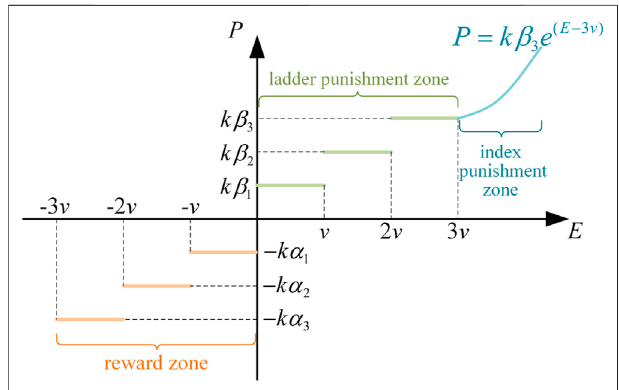
FIGURE 4 | The proposed tiered reward and punishment carbon trading